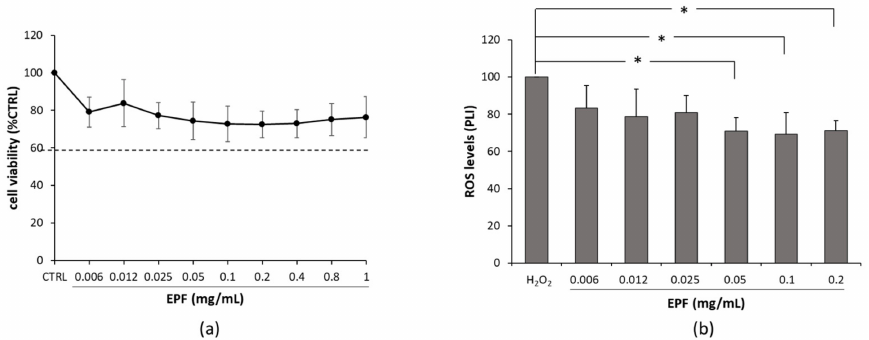
Figure 4. Effect of the enriched polysaccharide fraction on cell viability and reactive oxygen species (ROS) production in DI-TNC1 (ATCC CRL-2005) cell line. ( a ) Dose–response curve of cell viability, expressed as percentage of cell survival in comparison with control. The horizontal dashed line, set at 60%, indicates the threshold of cell viability. ( b ) ROS production is expressed as relative percentage of photoluminescence intensity (PLI) versus positive control (H 2 O 2 ). Values are mean ± SD of n = 3 experiments performed on different cell populations. Statistically significant decrease in comparison with H 2 O 2 . is indicated by asterisks (one-way ANOVA followed by Dunnet’s post hoc test; * p <